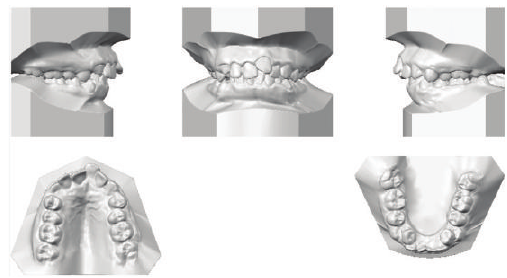
Figure 10: Stage 1: Orthodontic Treatment Final Models.